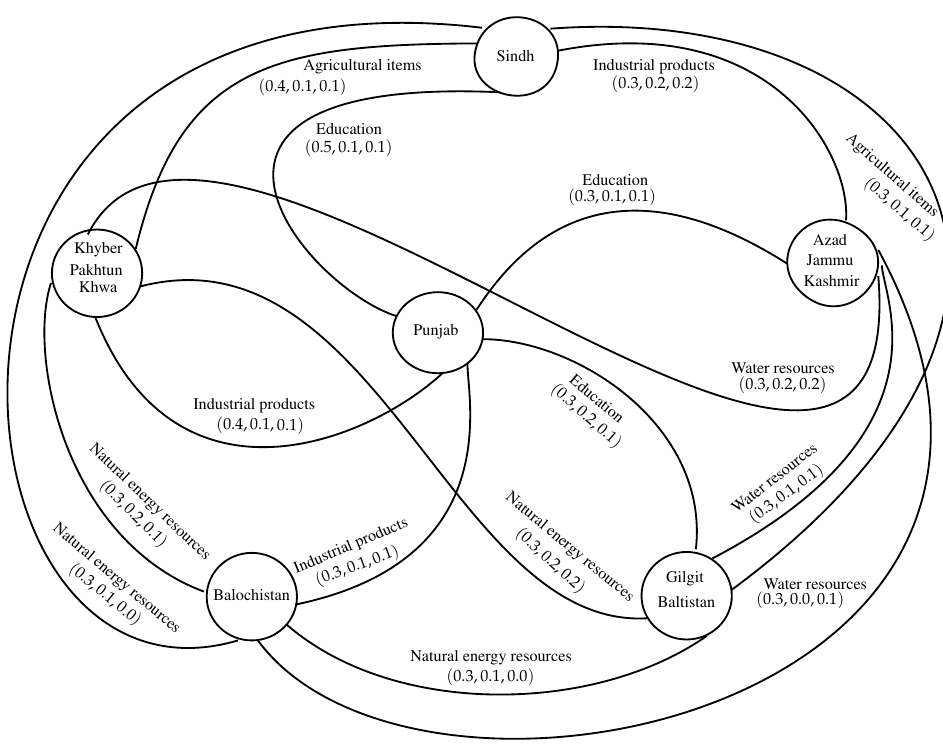
Figure 14. INGS identifying crucial interdependence relation between any two